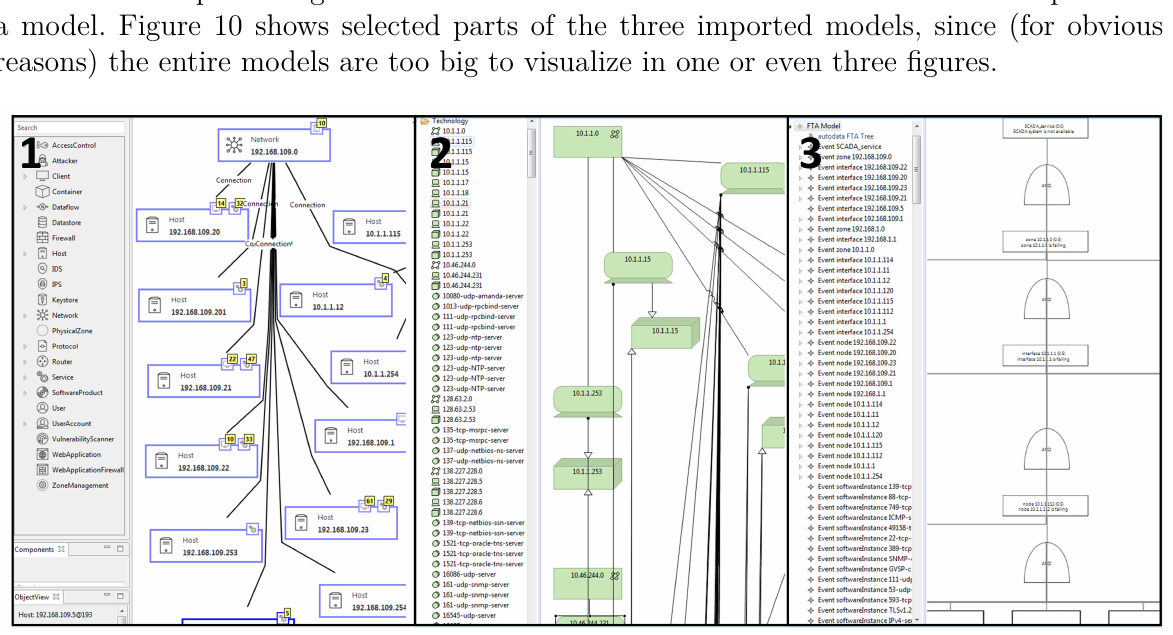
Figure 10. The securiCAD (1), Archi (2) and EMFTA (3) models as created using the